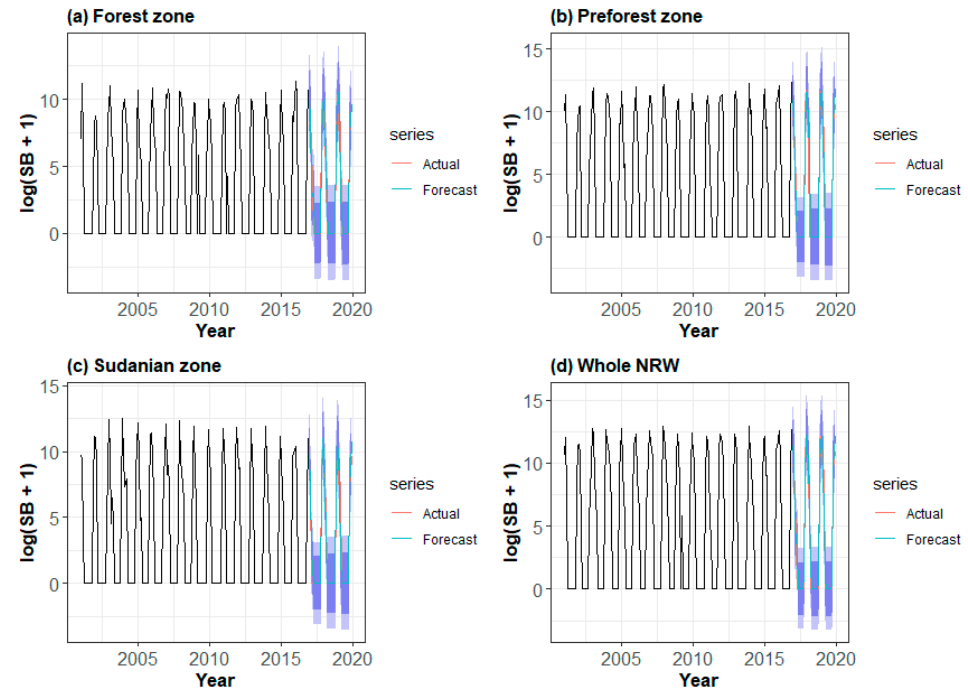
Figure 5. Forecasts of the number of wildfires in the (a) forest zone, (b) pre-forest zone, (c) Sudanian zone, and (d) whole NRW using the training dataset.